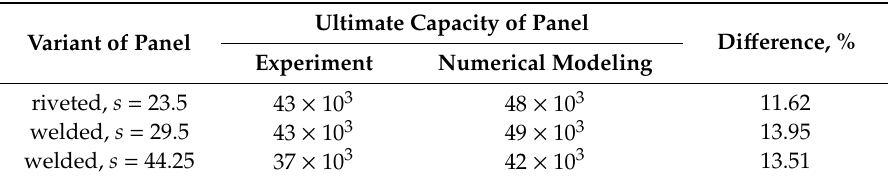
Table 2. Comparison of experimental and numerically predicted load capacities of the panels. Variant of Panel Difference, %